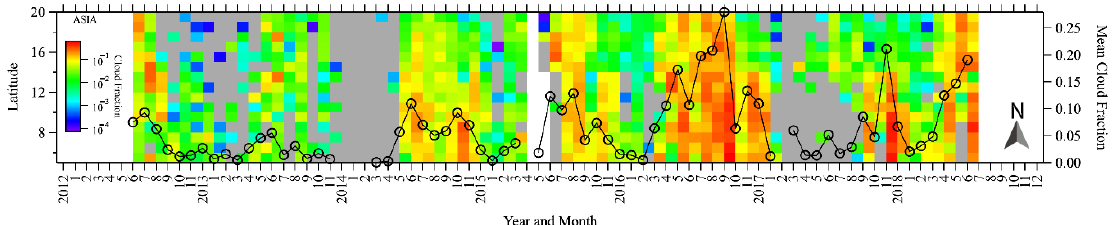
Figure 5. Hövmoller diagram during the period 2012–2018 for the Asian region showing monthly latitudinal averaged cirrus cloud fraction and the monthly averaged cirrus cloud fraction for the entire